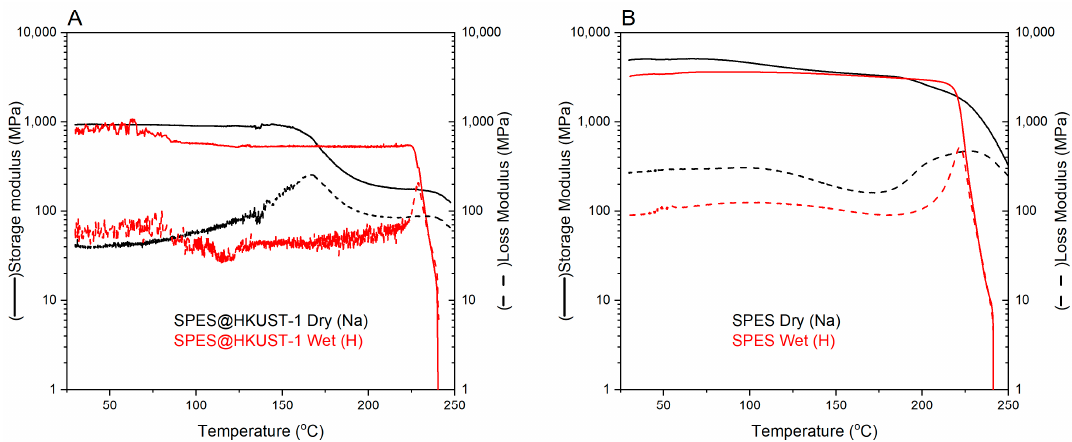
Figure 7. DMA curves for ( A ) the SPES@HKUST-1 membrane and ( B ) the pristine SPES mem- brane.